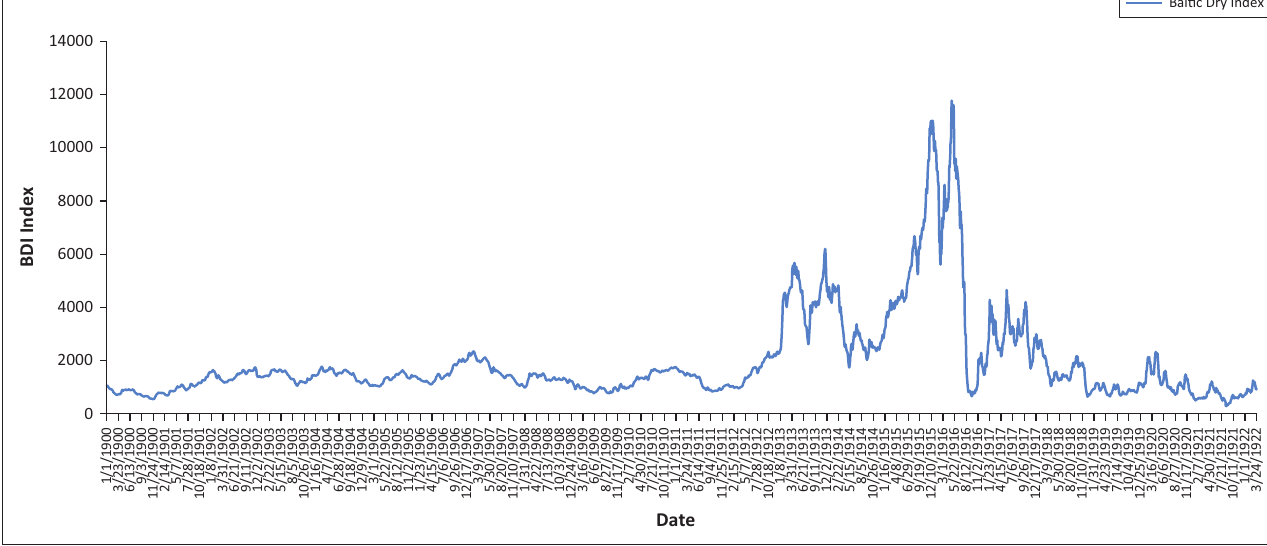
FIGURE 1: Baltic Dry Index price chart,